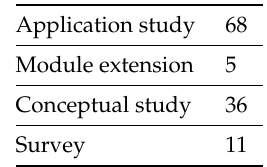
Table 11. Type of